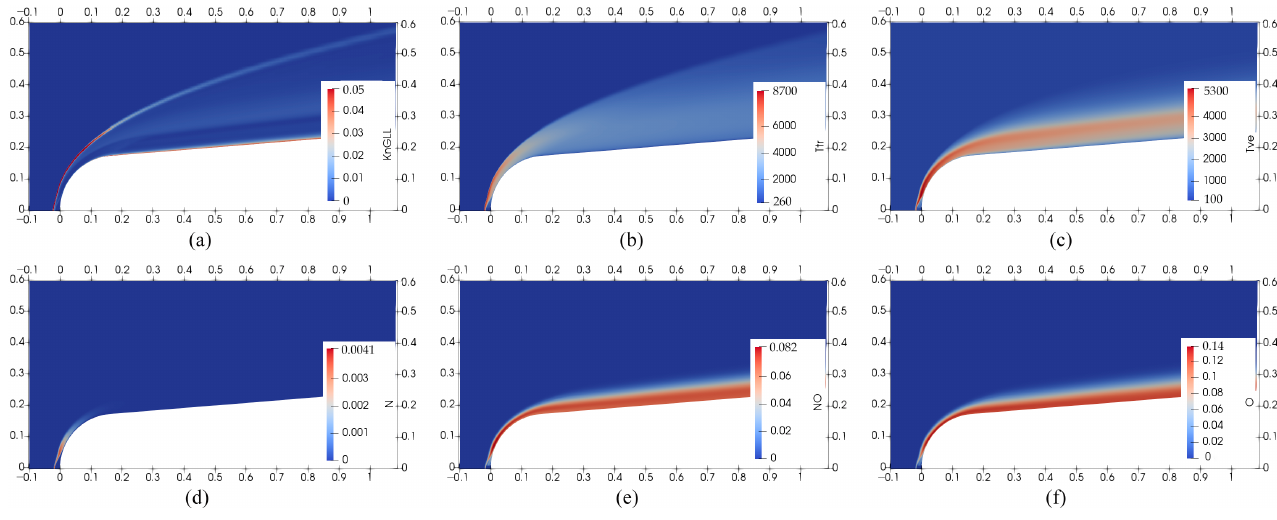
Figure 4. Flow features around ELECTRE with R7 jet in case 1. ( a ) Local Knudsen number ( Kn GLL ). ( b ) Trans-rotational temperature ( T tr ). ( c ) Vibro-electronic temperature ( T ve ). ( d ) Mass fraction of nitrogen atom (N). ( e ) Mass fraction of nitric oxide (NO). ( f ) Mass fraction of oxygen atom (O).